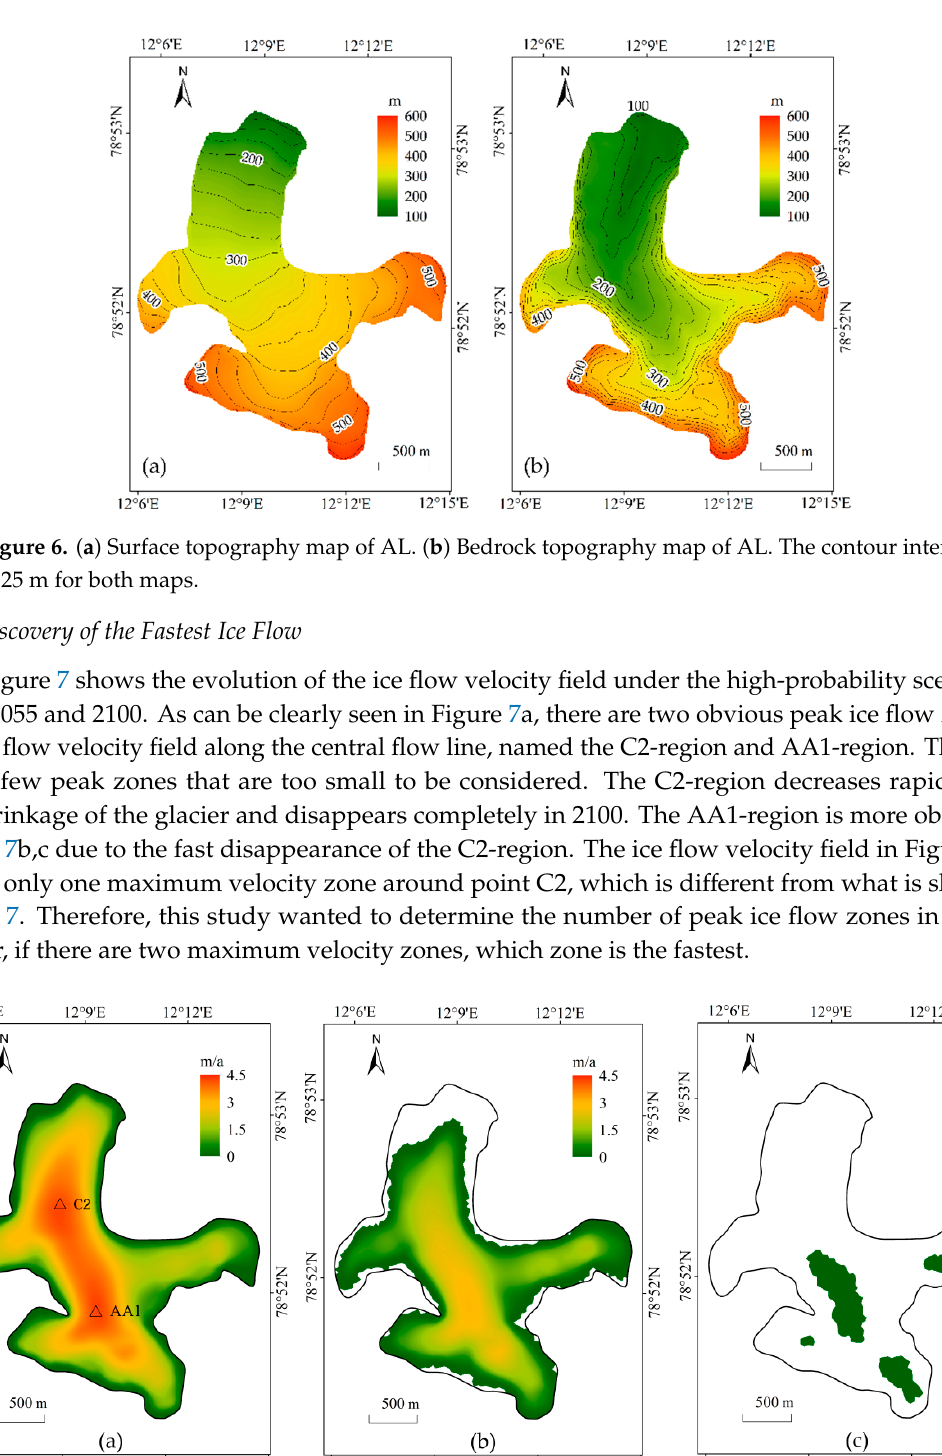
Figure 8. Simulated glacier areas as a function of time under three hypothetical climate scenarios, 2010~2100. To verify the simulation results, a new stake, named AA1, was established in the potential maximum velocity zone in May 2016. Due to reasons beyond the authors control, field observation missions have not been carried out regularly in the past three years. The entire field work was